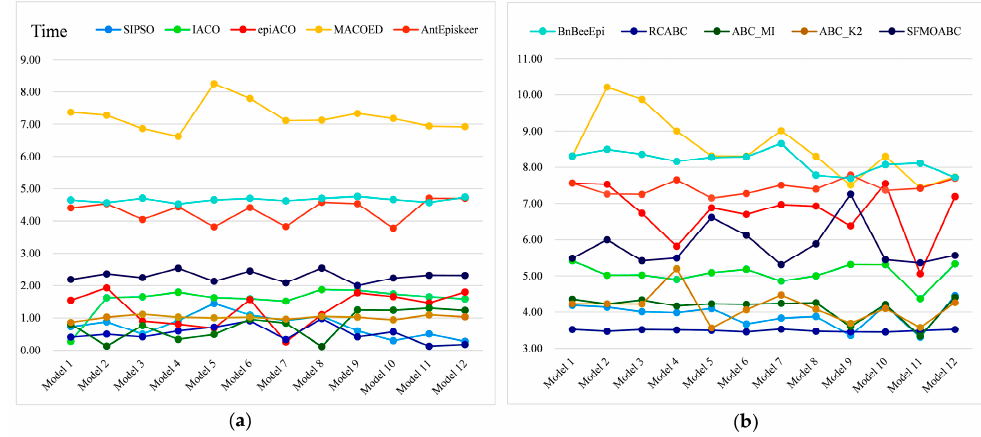
Figure 7. Running time: ( a ) Running time on the small-scale datasets; ( b ) Running time on the large-scale datasets.